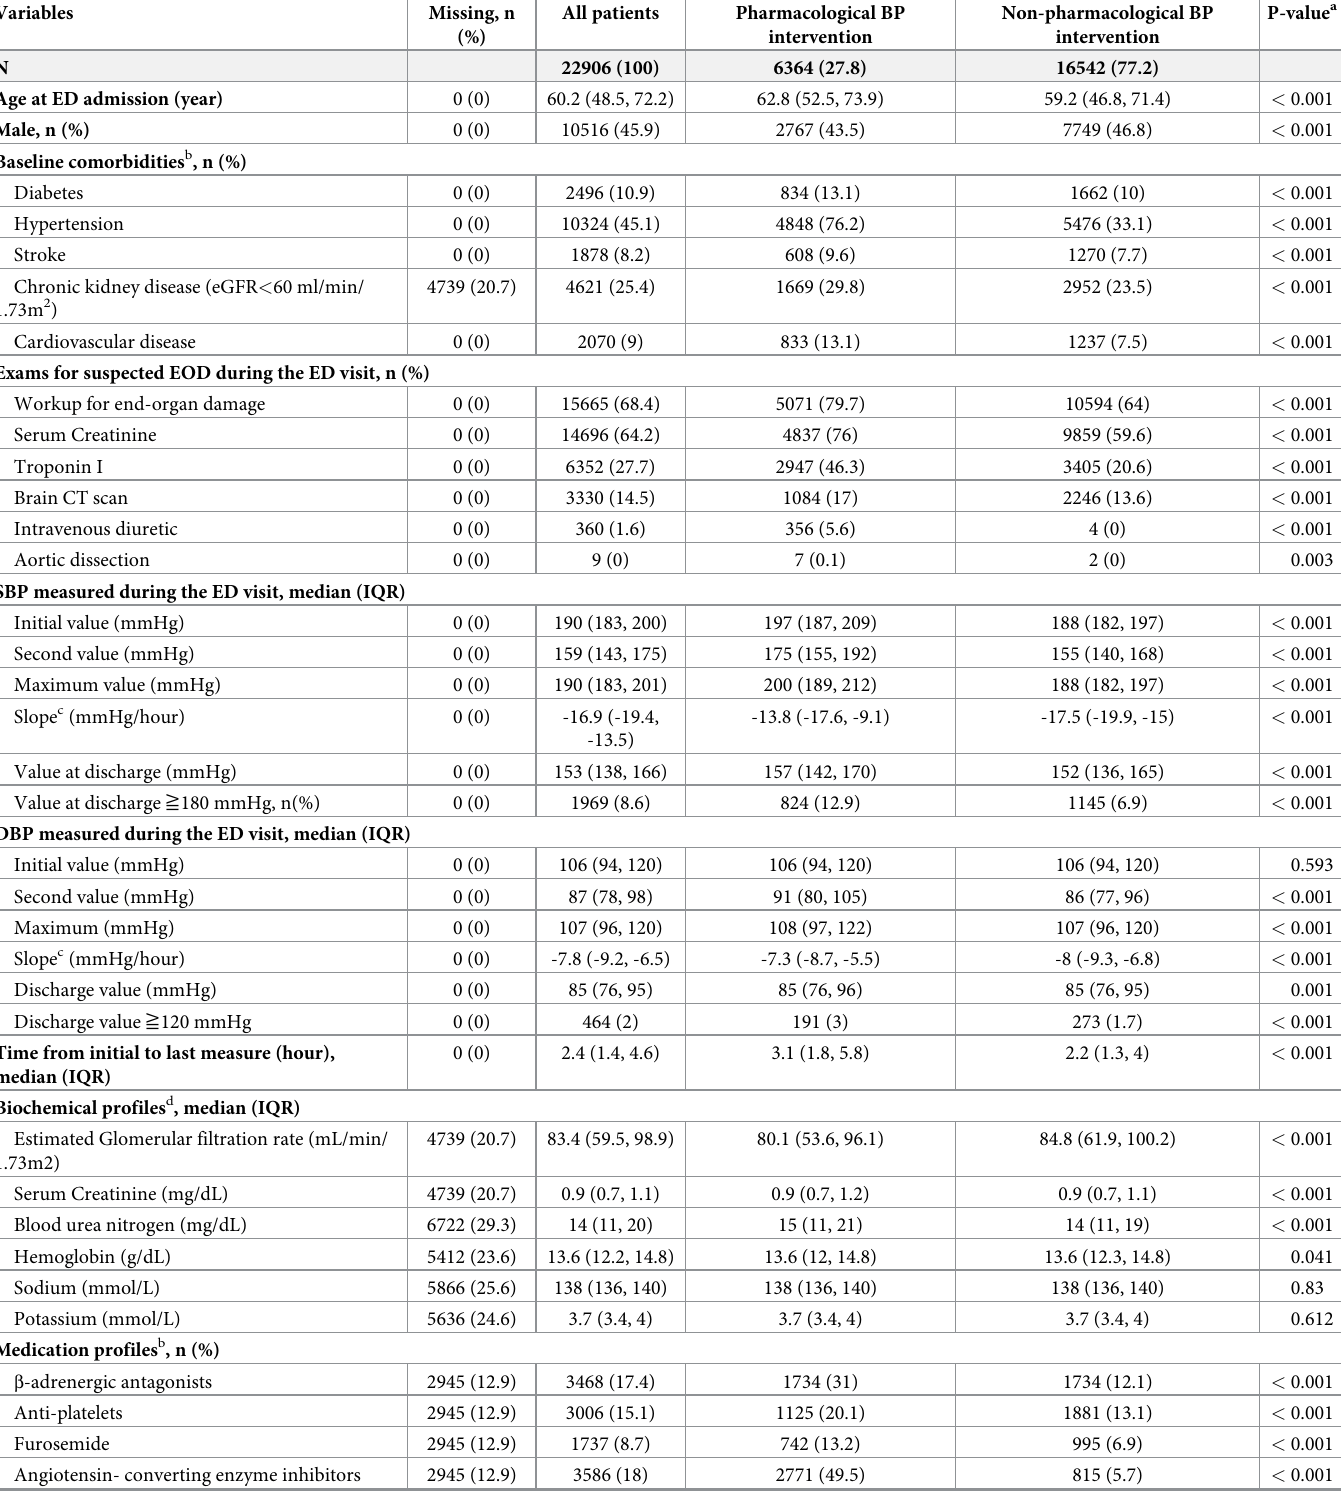
Table 1. Baseline demographic and clinical characteristics of the study